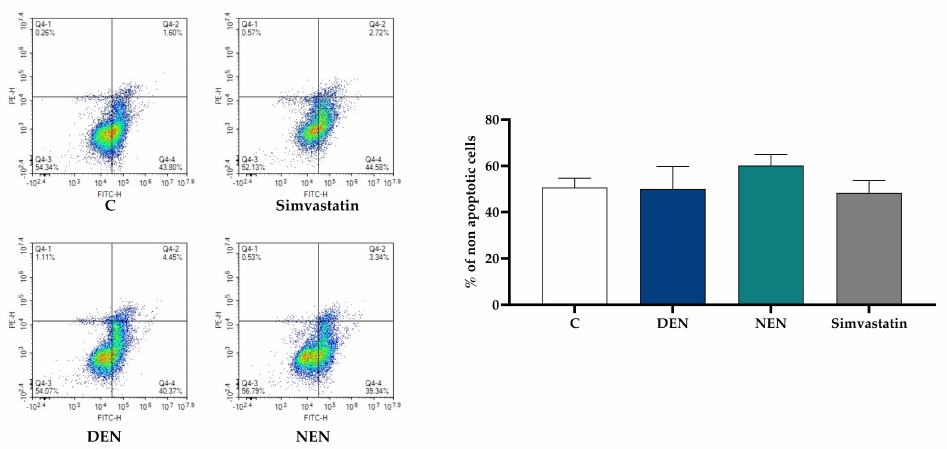
Figure 1. Impact of soy peptides on HepG2 cell viability. HepG2 cells were incubated with YVVN- PDN DEN (350 µ M) and YVVNPDN NEN (350 µ M) in MEM supplemented with 10% FBS for 24 h. Subsequently, they were stained with FITC annexin V and red-fluorescent propidium iodide. Simvas- tatin (20 µ M) was tested since it was used as a positive control of PCSK9 activation throughout the manuscript. At least three independent experiments were conducted. PCSK9, proprotein convertase subtilisin/kexin type 9; C, control (medium alone). DEN stands for YVVNPDN DEN and NEN stands for YVVNPDN NEN